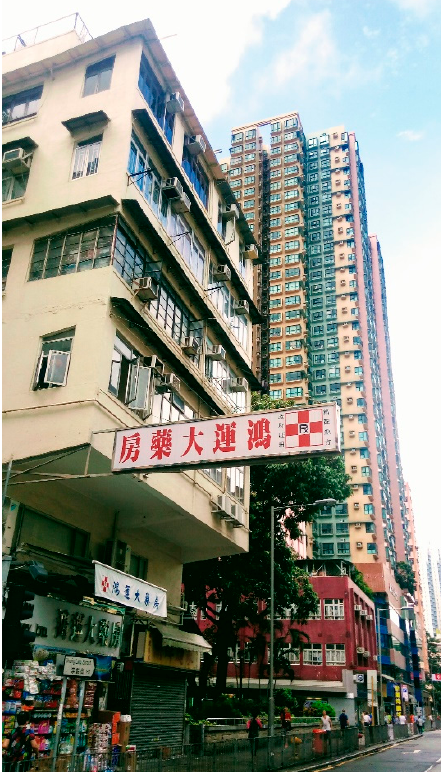
Figure 3. New development of single high-rise buildings in the community comprised of mostly “Long Lau”. Picture captured at San Po Kong, one of the socially deprived districts in Hong Kong.